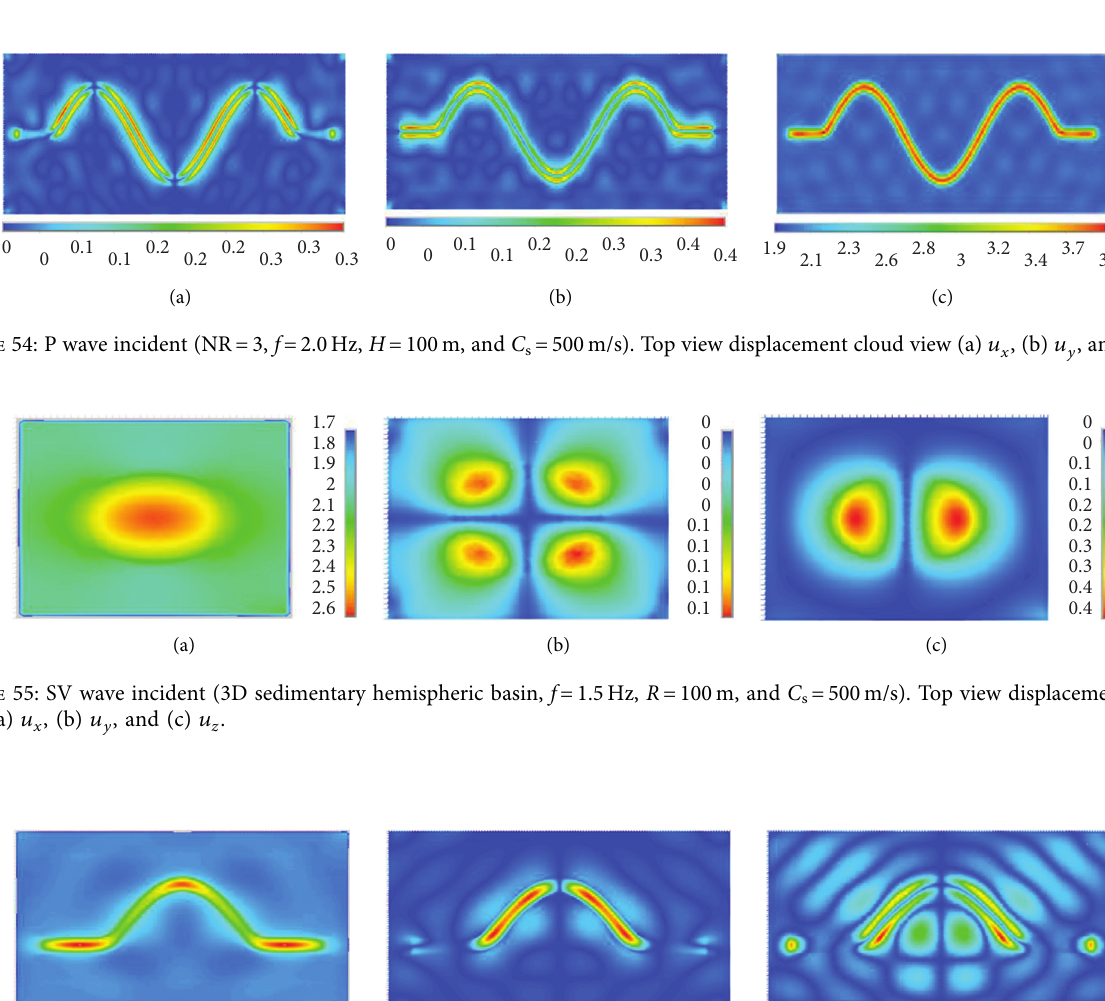
� 500m/s). Top view displacement cloud view (a) u s